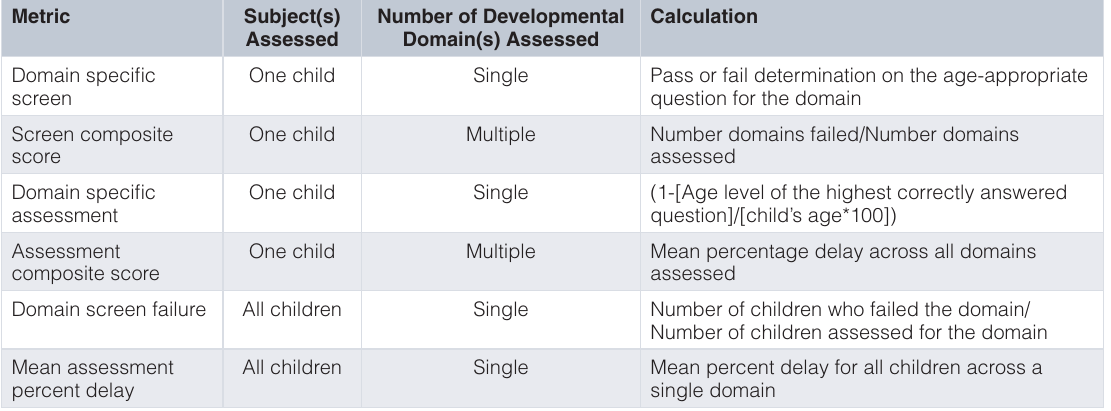
Table 1. Definitions of tool metrics on the PEDS:DM.